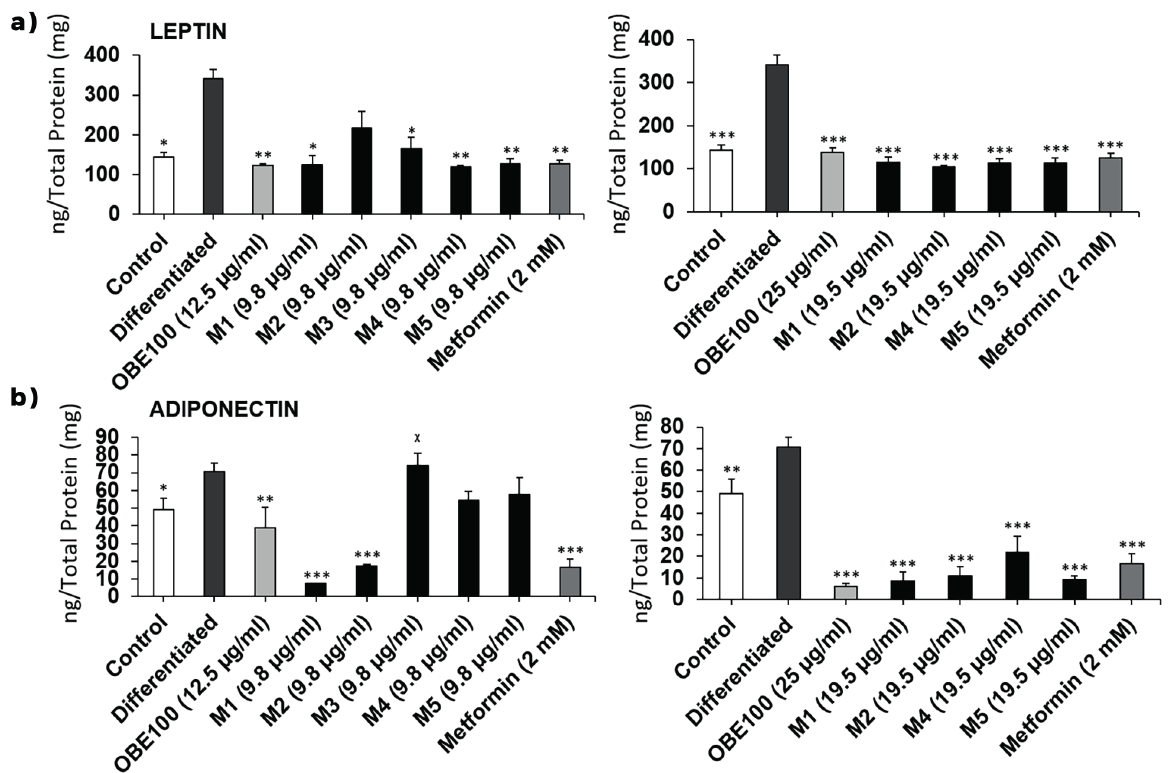
Figure 6. Effect of triterpenoid mixtures on protein expression in 3T3-L1 adipocytes. Differentiated 3T3-L1 cells were treated with OBE100, M1, M2, M3, M4 and M5. (a) Amount of leptin and (b) Amount of adiponectin present in the supernatant of the cells after 7 days of treatment. Values are expressed as mean ± SEM of three independent experiments. *< 0.05 vs Differentiated, ** < 0.01 vs Differentiated, ***< 0.001 vs Differentiated, x < 0.05 vs OBE100 (ANOVA with Dunnett´s post hoc